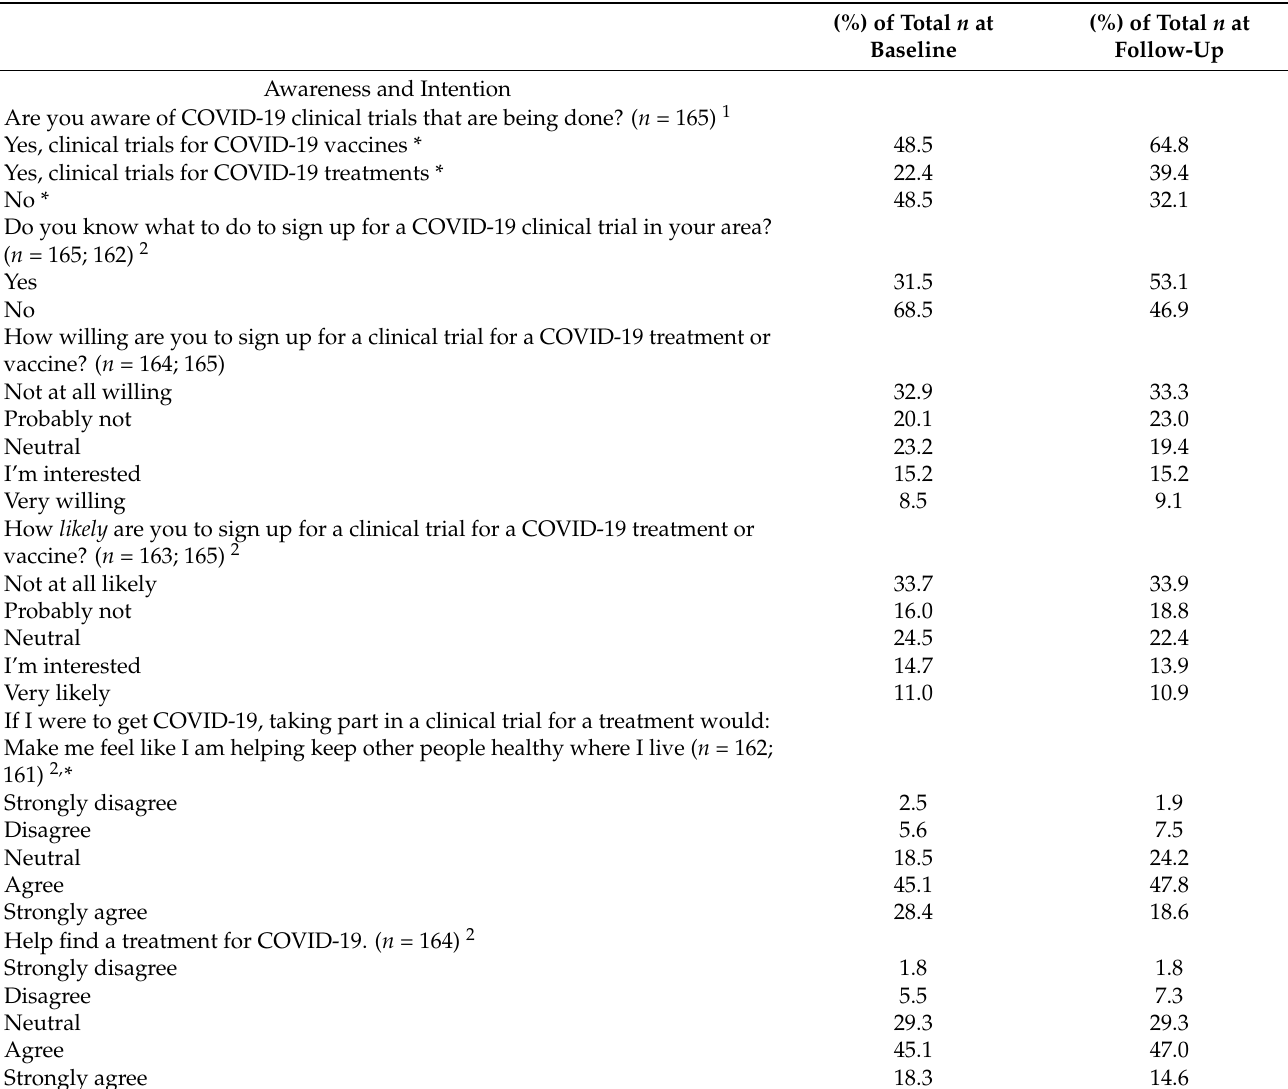
Table 2. Respondent awareness of and attitudes toward COVID-19 clinical